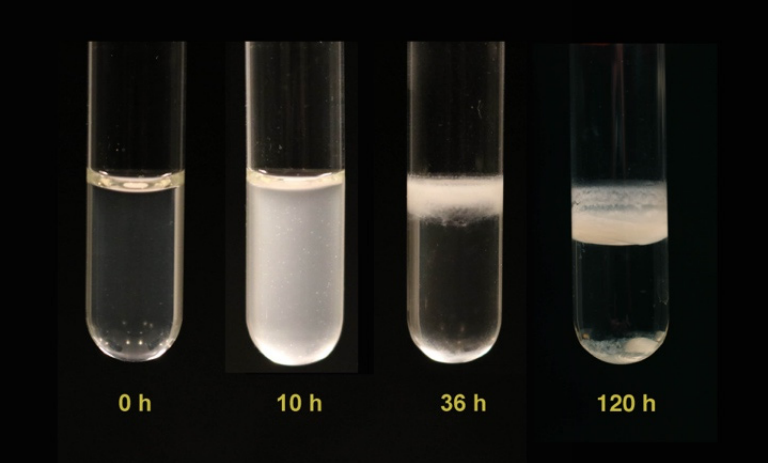
Figure 1. Biofilm formation and planktonic growth in glass tubes. The Bt407 strain was grown, in static conditions at 30 °C, in HCT medium and in glass tubes. Pictures were taken at the start of the experiment (0 h), and after 10, 36 or 120 h of incubation.